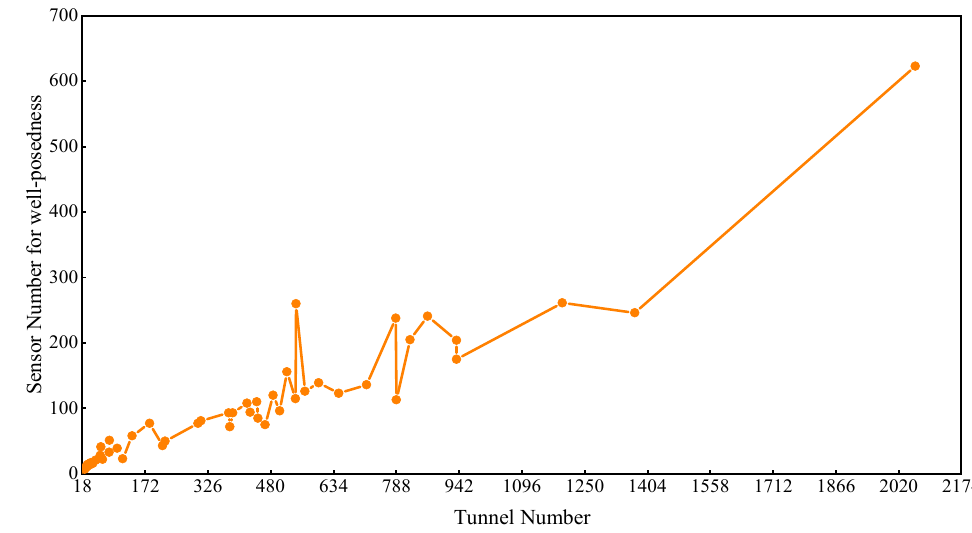
Figure 3. The number of sensors required for well-posed reconstruction.